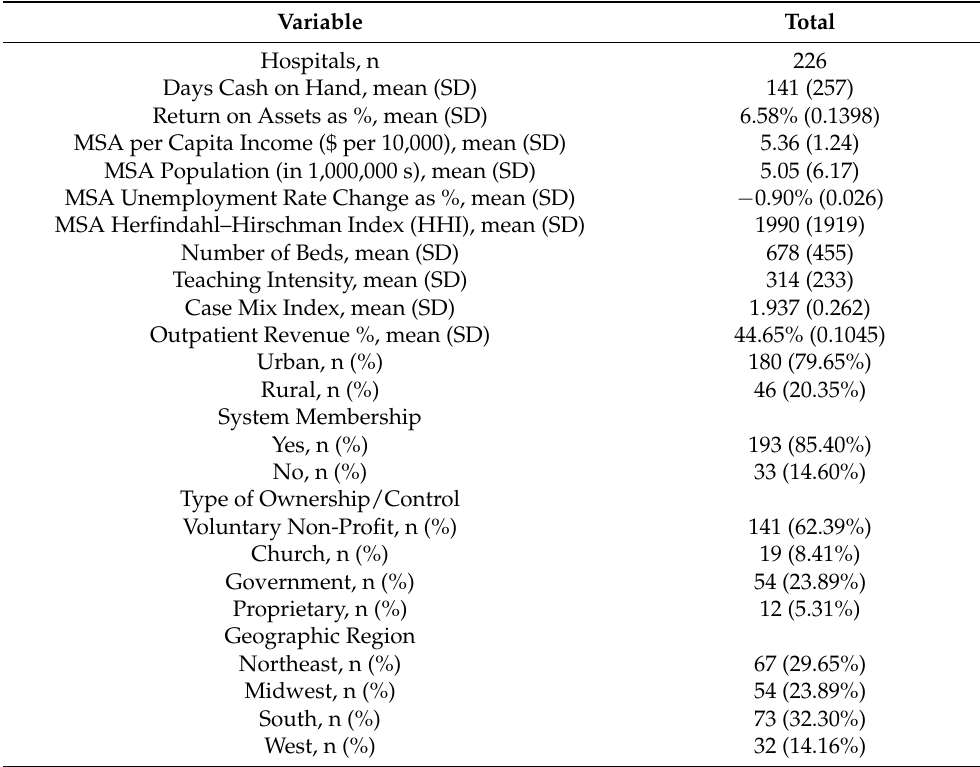
Table 2. Descriptive Statistics and Hospital Characteristics.